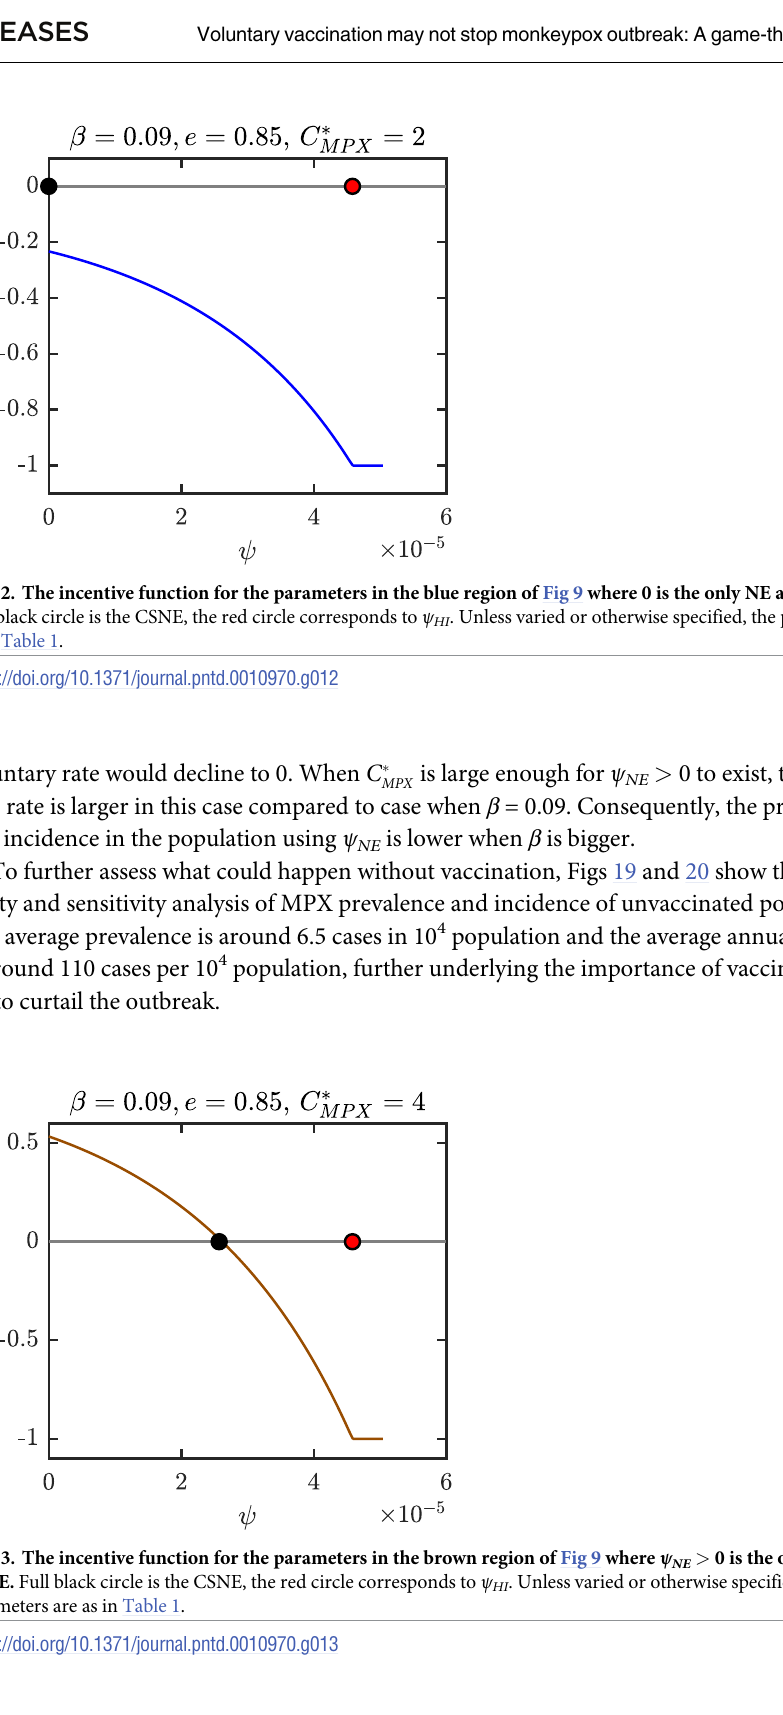
. Unless varied or otherwise specified, the HI